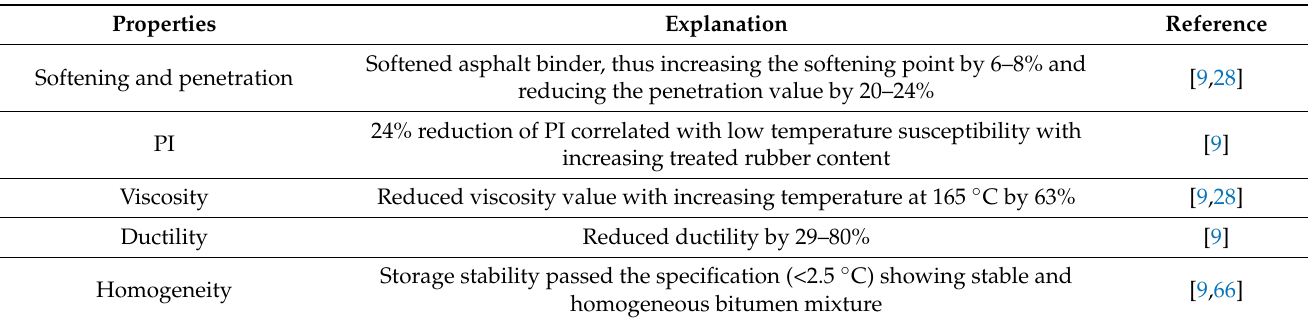
Table 16. Significant properties of toluene